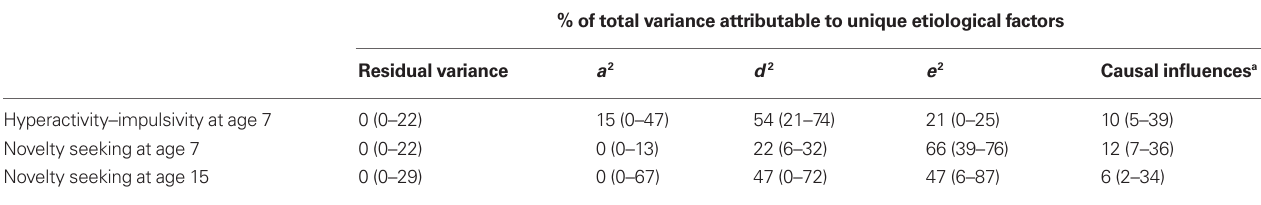
Table 3 | Parameter estimates ( + 95% confidence intervals) from the best fitting direction of causation